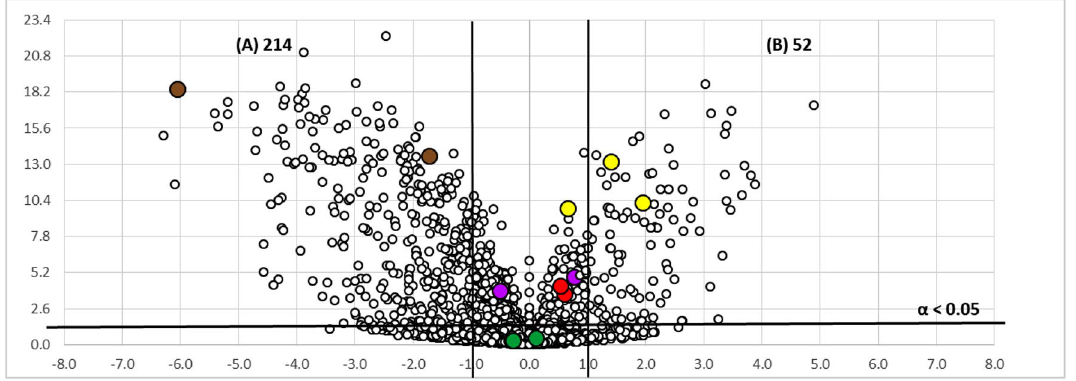
Figure 6. Volcano-plot statistical untargeted metabolomics comparison of the strain CF-090766 and CF-090361 cultured for 7 days in the same fermentation format (flasks of 250 mL), comparing the metabolite production by the two strains (− log 10 of t -test statistical p -value in y -axis vs . − log 2 of ion masses areas ratio in x -axes): strain CF-090766; strain CF-090361 (compound 1 in red, compound 2 in purple, compound 3 in brown, compound 4 in yellow and compound 5 in green). The number of statistically different mass ions due to higher production for each growth condition is indicated with statistical confidence of 95% (n = 10; α < 0.05) for each fermentation